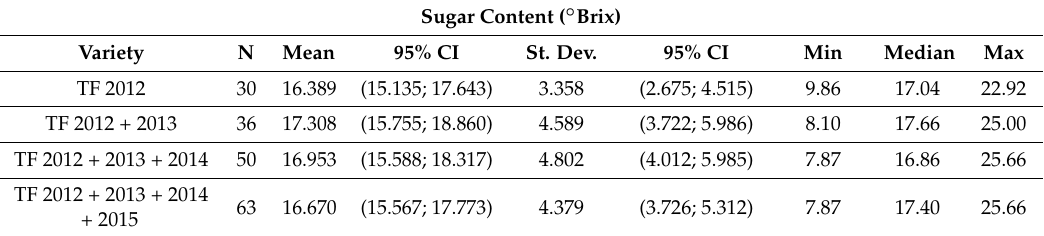
Table A9. Descriptive statistics of the samples used in the external test sets for the prediction of sugar content.